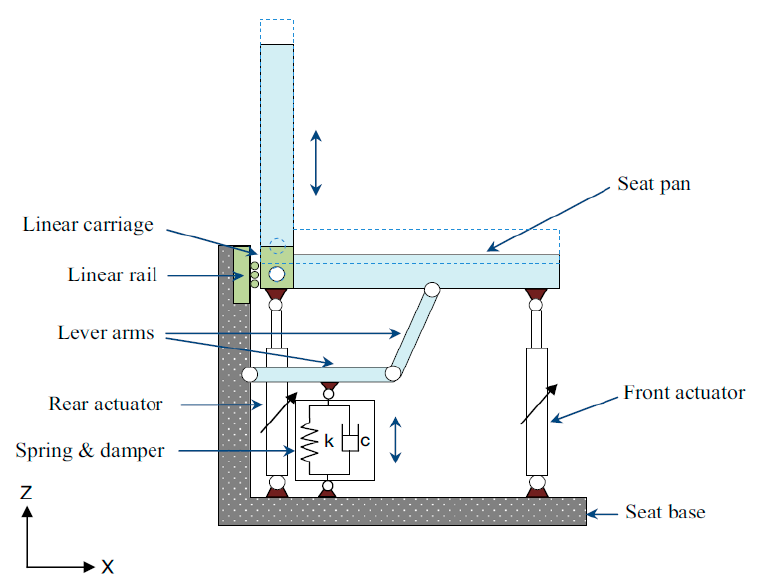
Figure 10. Mechanical design of active seating suspension system [70].